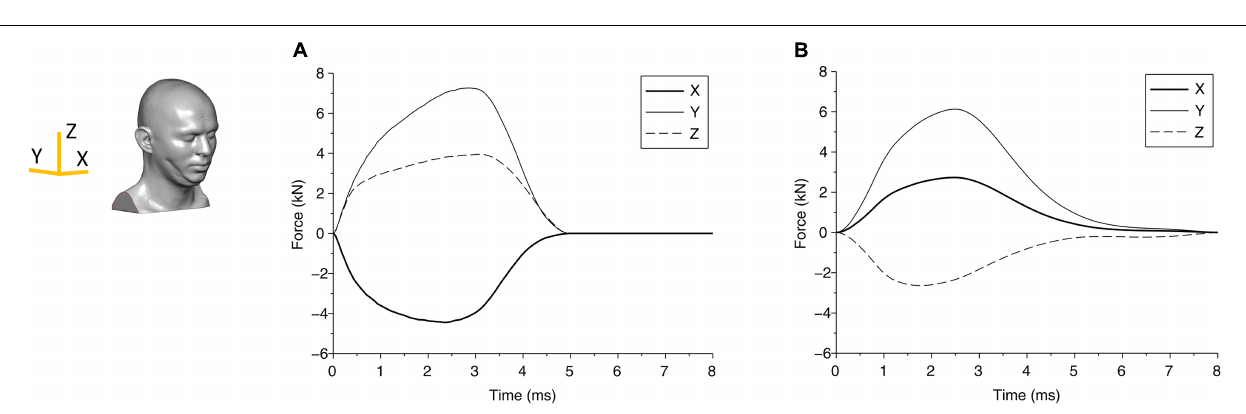
FIGURE 3 | The force components due to the blunt impact between the head and the impactor are shown for (A) case 1 and (B) case 2. The axes are shown in the head finite element (FE)